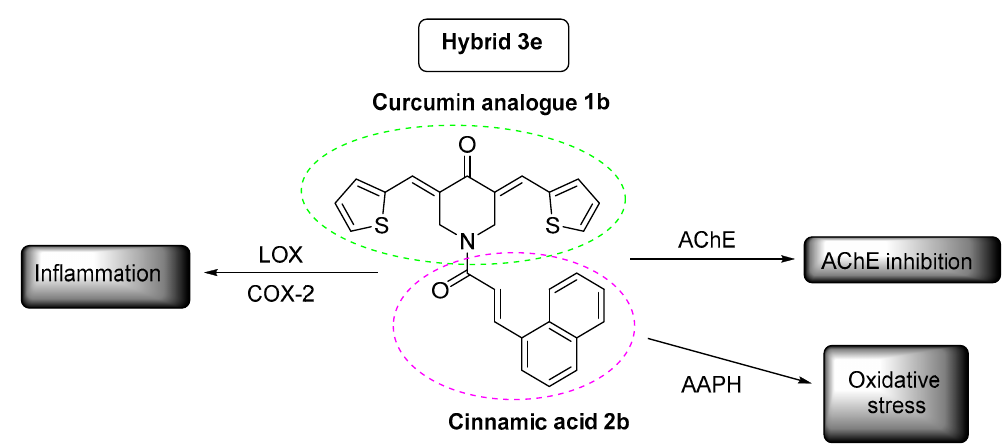
Figure 10. Hybrid 3e is presenting the most interesting profile.